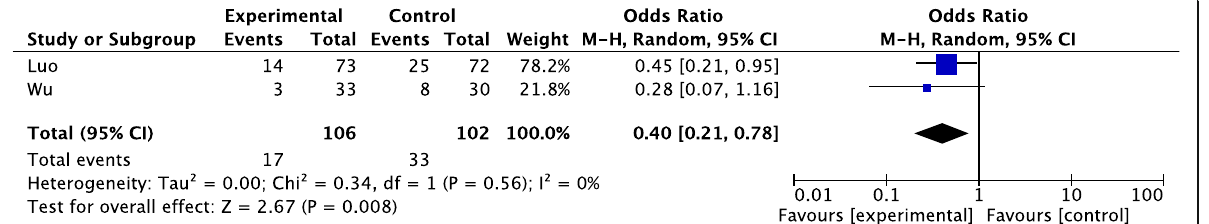
Fig. 5 Rates of postoperative complications in patients undergoing neurosurgery, with Odds Ratios (ORs) and 95% confidence intervals (CI). The pooled OR and 95% CI are shown as the total. The size of the box at the point estimate of the OR gives a visual representation of the “ weighting ” of the study. The diamonds represent the point estimate of the pooled ORs and the length of the diamonds is proportional to the